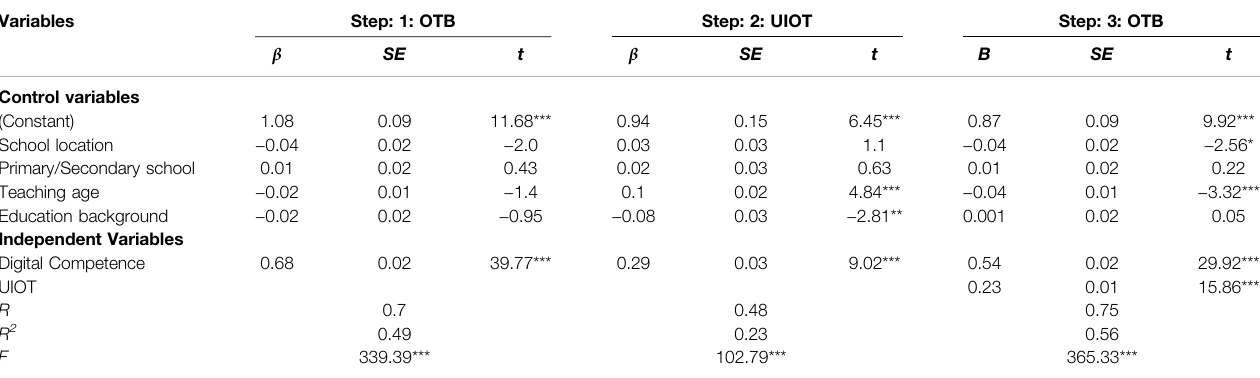
TABLE 2 | Analysis of use intention of online teaching, digital competence, and online teaching behavior. Variables